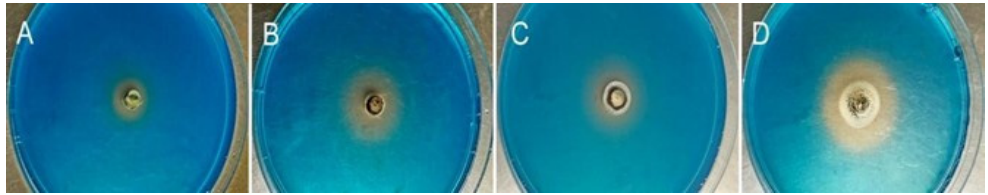
Figure 2 . Siderophore production of four isolates on CAS media. ( A ) HZ06. ( B ) HZ23. ( C ) HZ10. ( D ) HZ123.